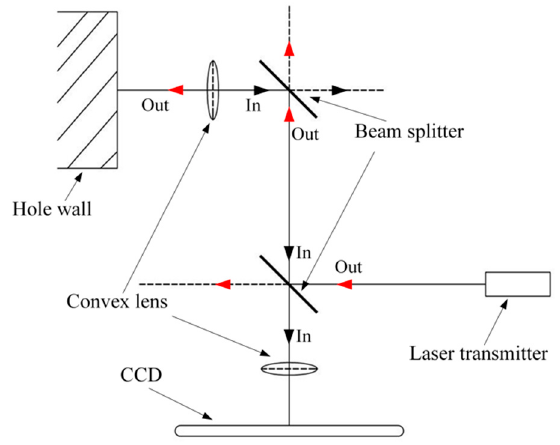
Figure 2. Optical path design of the measuring system.